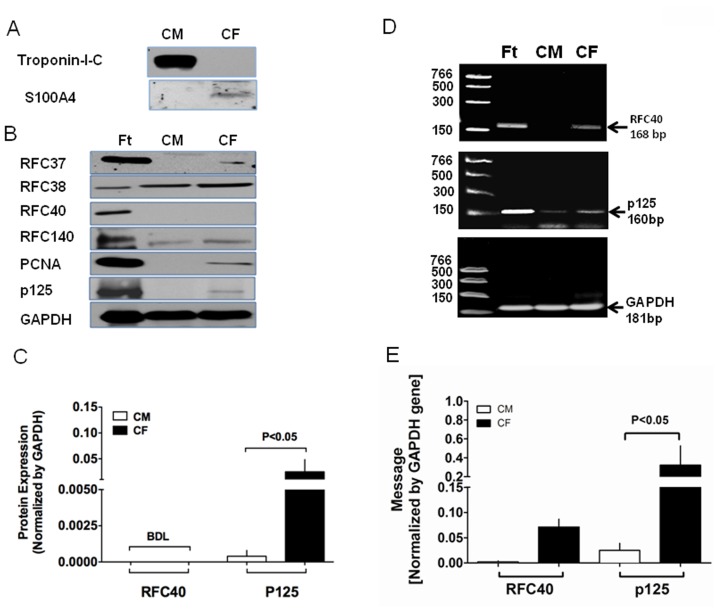
Differential expression of the DNA replication proteins in CMs and CFs.(A) CMs (n = 5) and CFs (n = 5) were isolated from normal adult heart and lysates (50 µg) were then analyzed by 12% or 9% SDS-polyacrylamide gels. Purity of the two fractions were confirmed by Western blot analyses for Troponin I-C (CMs) and S100A4 (CFs) proteins respectively. (B) Expression of RFC37, RFC38, RFC40, RFC140, PCNA and p125 proteins in the CMs and CFs was determined by Western blot analyses. Whole hearts isolated from 15 day-old fetus (n = 5) were used as a positive control (Ft). GAPDH was used as the loading control. (C) Graphs represent protein expression of RFC40 and p125, normalized by GAPDH in the CMs and fibroblasts, respectively. (D) Total RNA (50 ng) extracted from CMs and fibroblasts pellets (n = 5) was subjected to real-time one-step-RT-PCR. At the end of each run the amplified products of RFC40, p125 and GAPDH mRNA/cDNA were visualized on 3% agarose gels. Total RNA extracted from whole hearts of 15 day-old fetus (n = 5) were used as a positive control (Ft). (E) Graphs represent the mRNA levels in the CMs and CFs calculated from the crossing point deviation and normalized by GAPDH values. Values are mean ± SE. BDL: Below detectable levels.